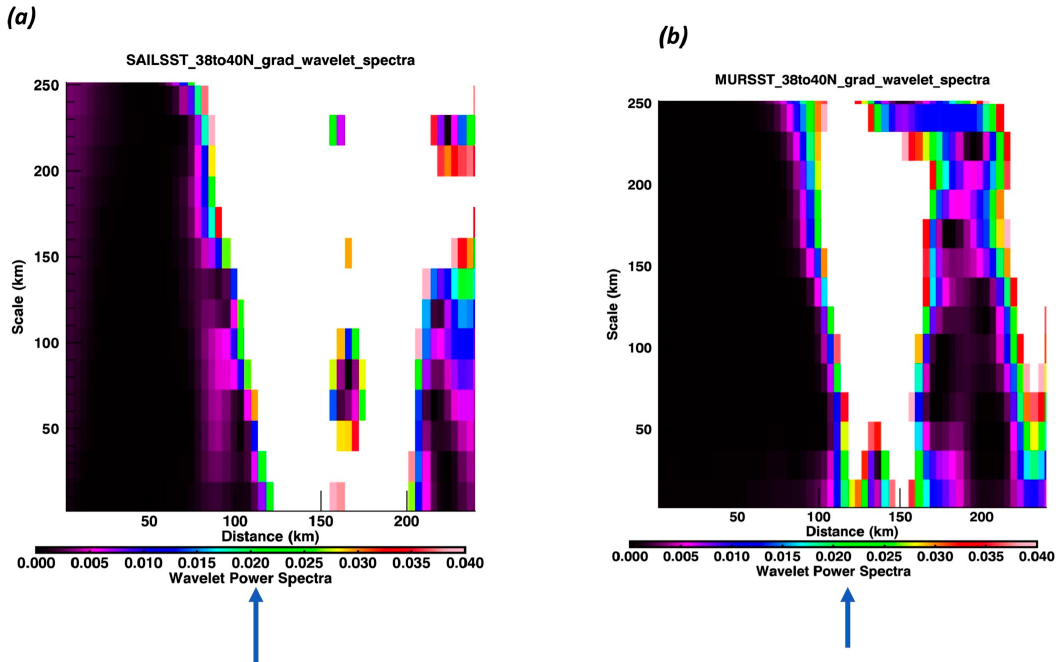
Figure 6. ( a , b ). Wavelet spectra from 38°N to 40°N for ( a ) SAILSST and ( b ) MURSST. Arrows indi- Figure 6. ( a , b ): Wavelet spectra from 38 ◦ N to 40 ◦ N for ( a ) SAILSST and ( b ) MURSST. Arrows indicate cate the color associated with the 95%level of confidence. the color associated with the 95%level of